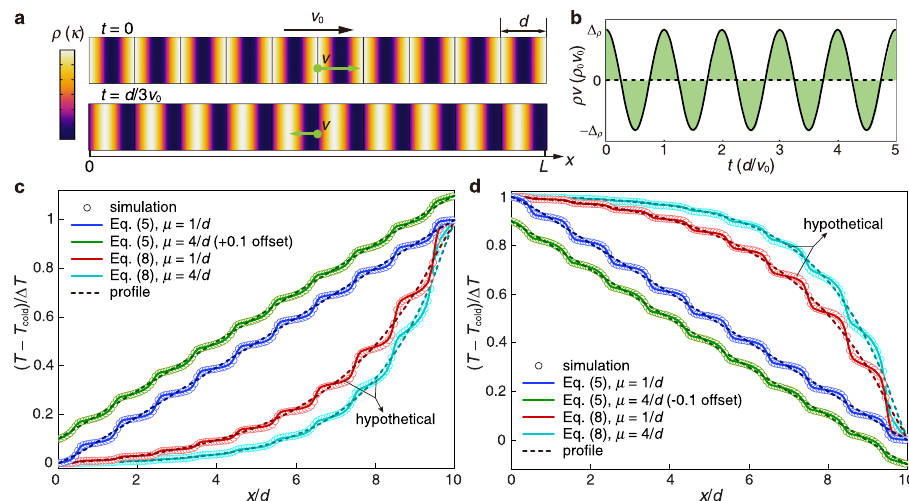
Fig. 2 Heat transfer under 1D density modulation. a Density ρ and thermal conductivity κ (color maps) move as traveling waves at speed v 0 with wavelength d . To achieve density modulation, actual mass movements (green arrows) at speed v must exist. b The total mass fl ux in a time period should be zero to keep a cyclic and close setup. c , d Backward ( c ) and forward ( d ) temperature distributions of the system (Eq. (5)) at t = Nd / v 0 ( N is a large enough integer to achieve time-harmonic steady state), compared with those of a virtual system without mass movements (Eq. (8)). Scatter points are simulated results, lines are analytical results, and dashed lines are analytical solutions of the homogenized pro fi les. For clarity, the results of Eq. (5) at modulating speed μ = 4/ d are shifted to have ±0.1